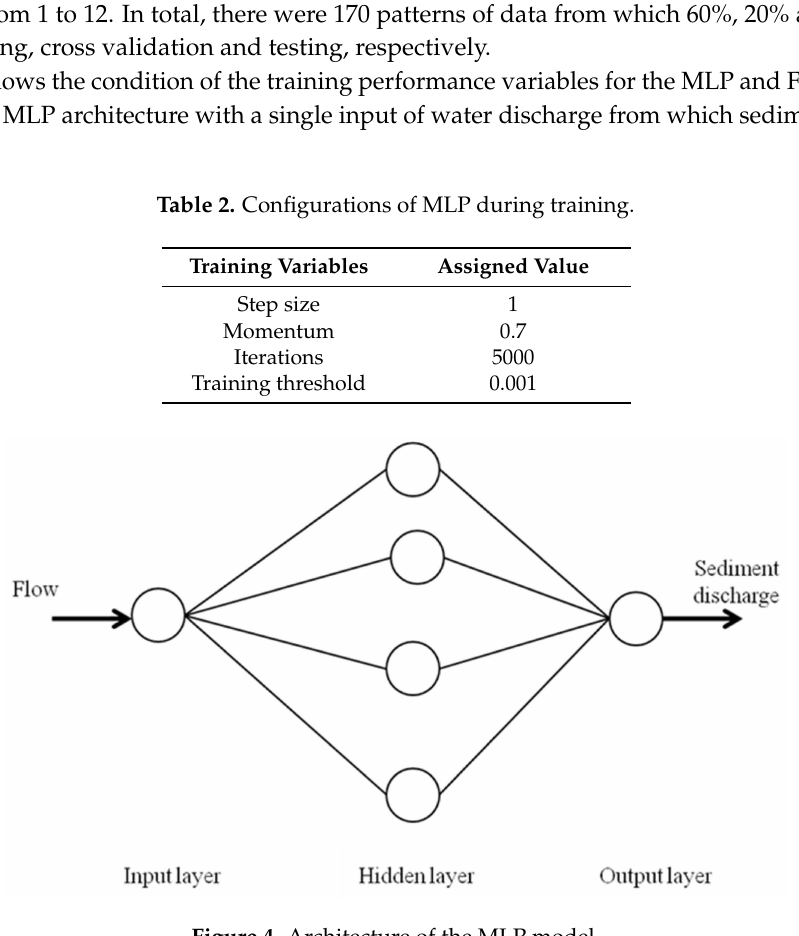
Figure 4. Architecture of the MLP